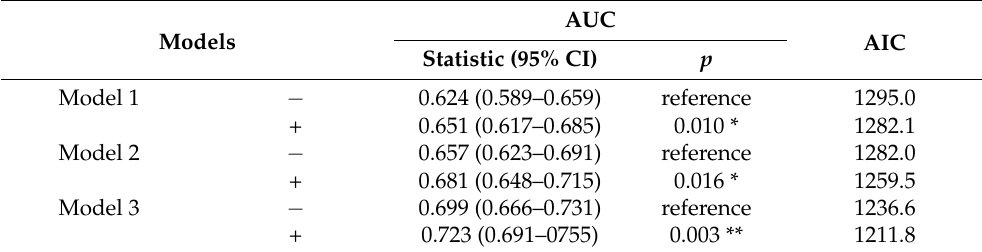
Table 3. Predictive models